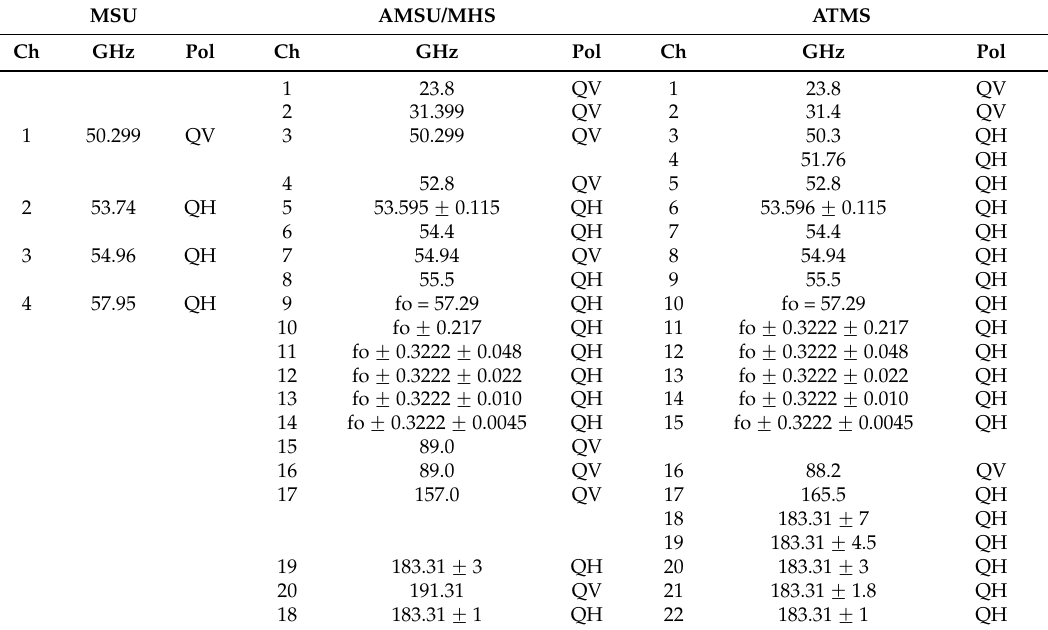
Table 1. Comparison of Microwave Sounding Unit (MSU), Advanced Microwave Sounding Unit/Microwave Humidity Sounder (AMSU/MHS) and ATMS channel center frequency and polarization. MSU AMSU/MHS ATMS Ch GHz Pol